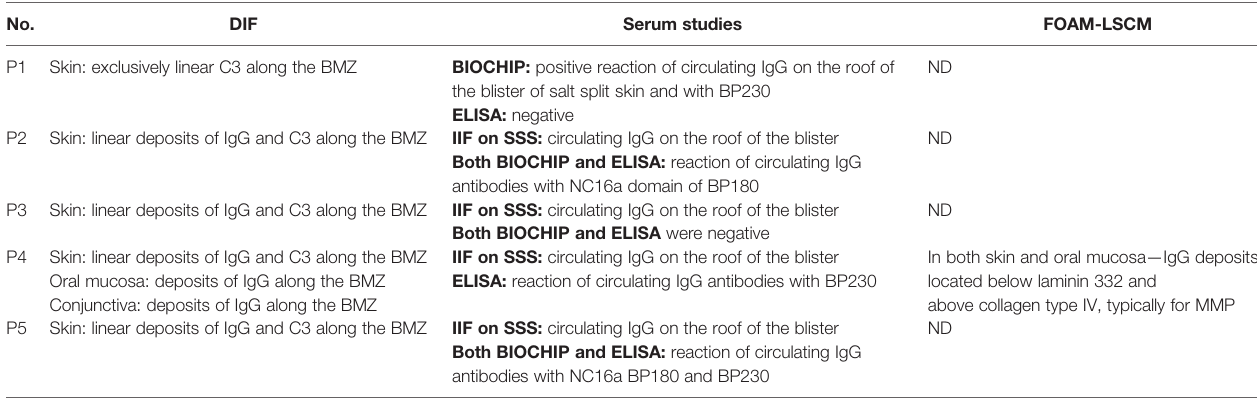
TABLE 2 | Immunological characteristics of patients included in the study. No.